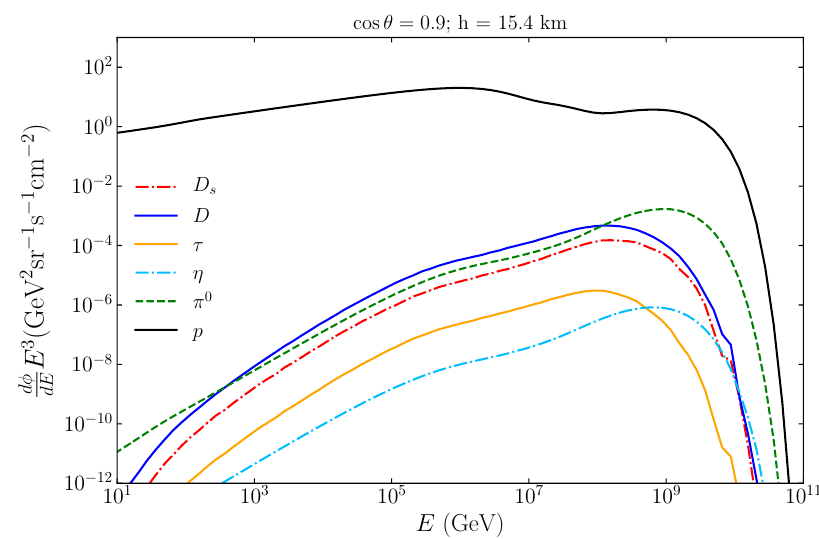
Figure 1 . Di(cid:11)erential (cid:13)uxes of LLP parent particles as a function of the energy at (cid:12)xed height in the atmosphere, h = 15 : 4 km.